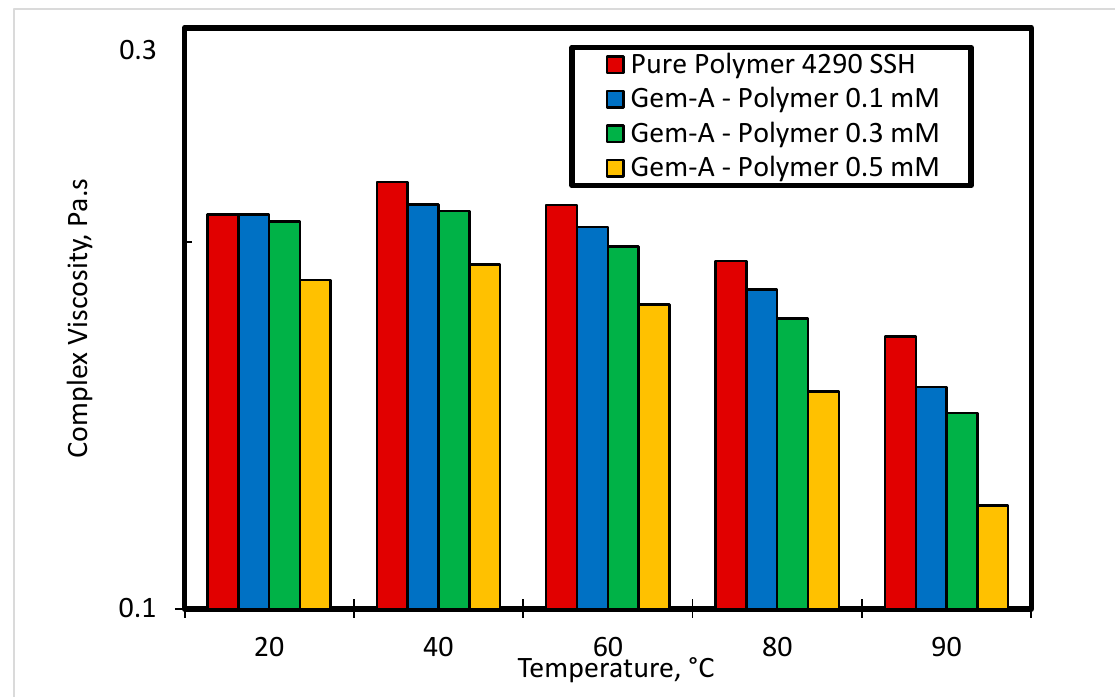
Figure 14. Effect of temperature on complex viscosity at different concentrations of Gem-A in the SP Figure 14. E ff ect of temperature on complex viscosity at di ff erent concentrations of Gem-A in the SP system at angular frequency 10 rad/s. system at angular frequency 10 rad /